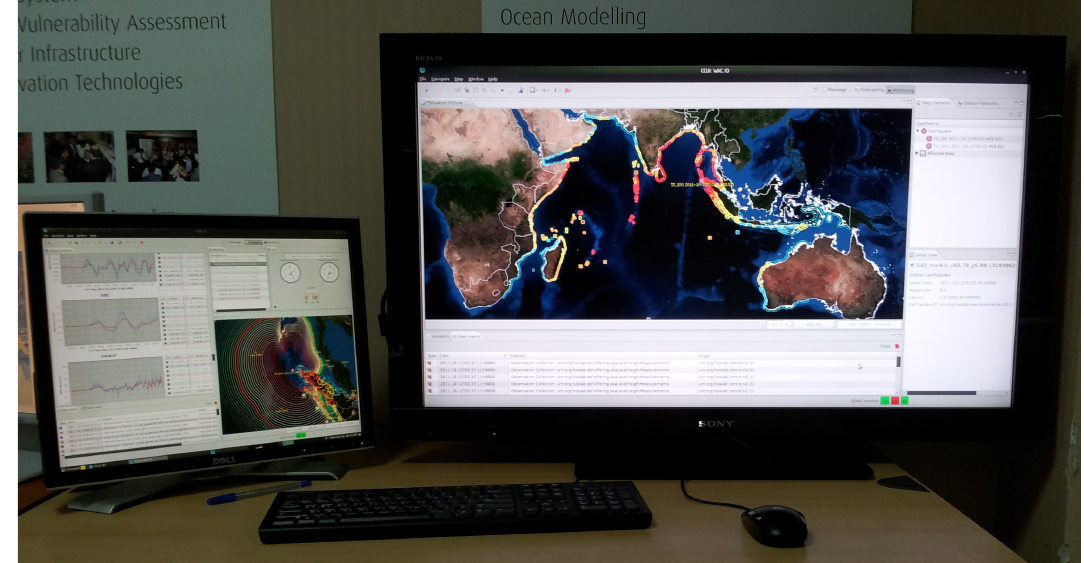
Fig. 14. CCUI version (right screen) used for international communication with national CCUIs, e.g. with the CCUI version (left screen) for Indonesia, both deployed at